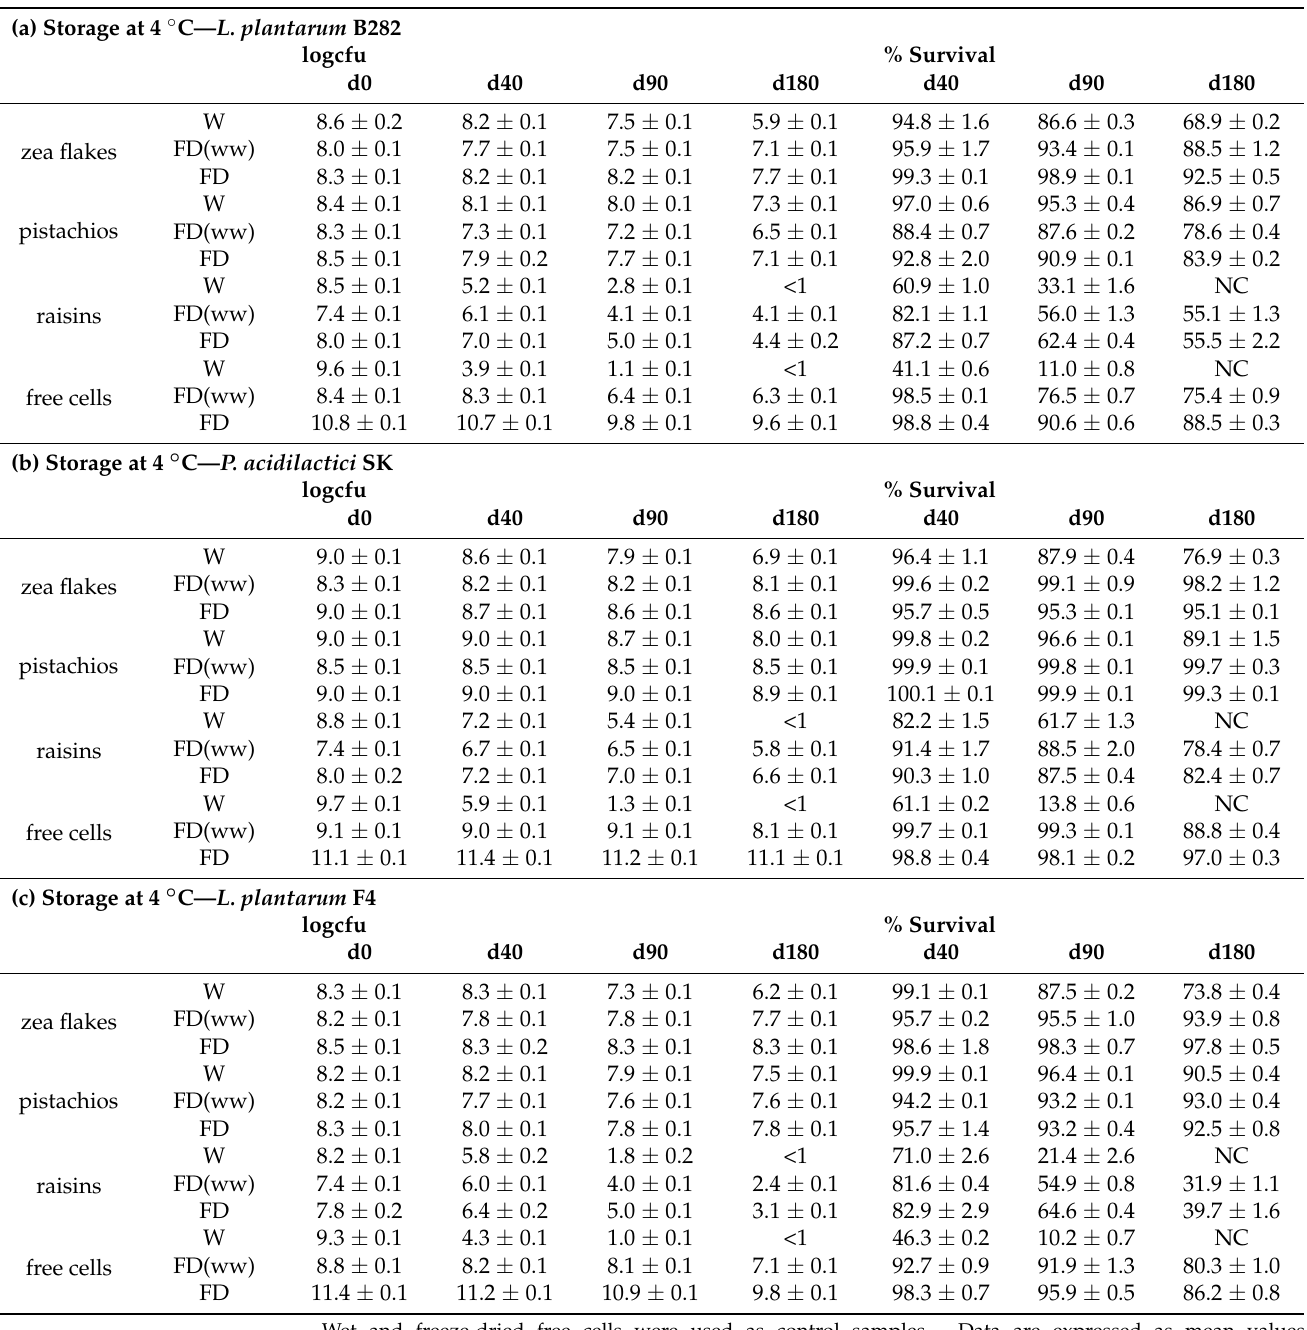
Table 3. ( a – c ) Effect of immobilization and storage at 4 ◦ C on cell levels and survival